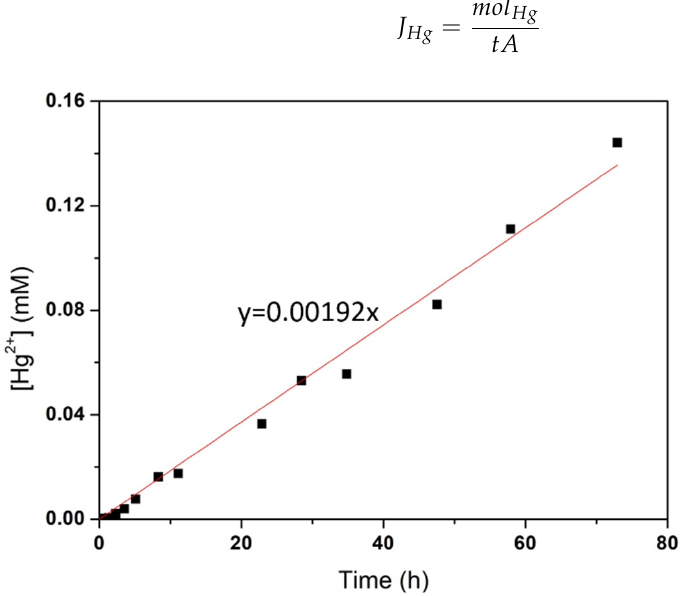
Figure 5. Hg 2+ concentration over time in compartment A of the diffusion cell. The concentration of Hg 2+ was determined by ICP-AES with an associated error <5%.